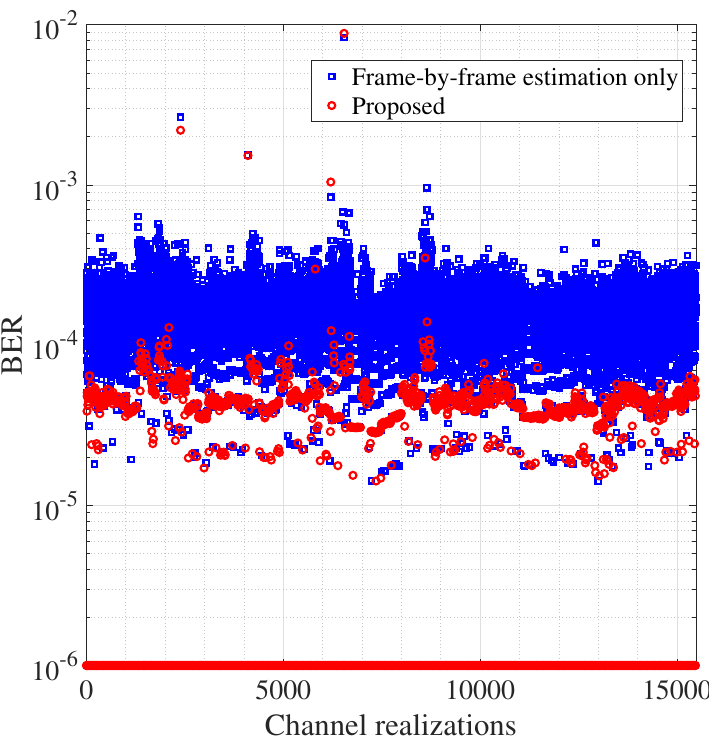
Figure 6. BER for different channel realizations for the proposed scheme and the case with frame-by- frame estimation and quantized feedback.